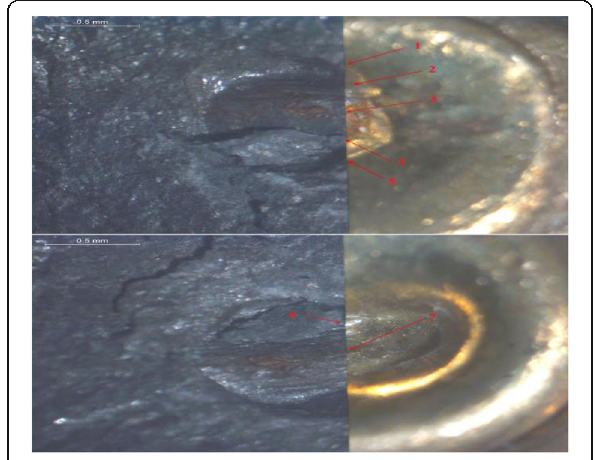
Fig. 5 Showing comparison of firing pin and breech face marks on cartridge case with impression on lead (magnification 10 × 2 =